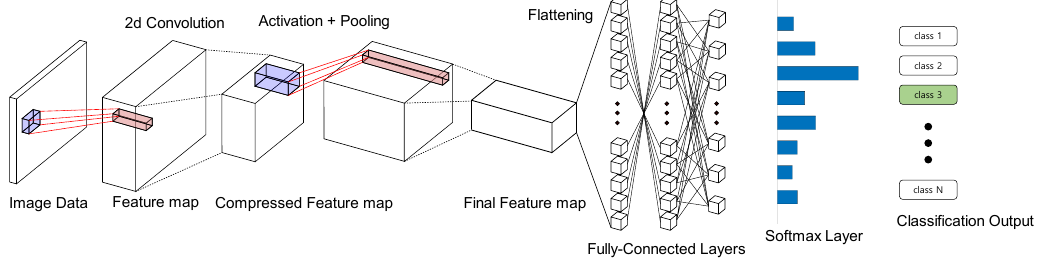
Figure 2. Typical architecture of CNN.